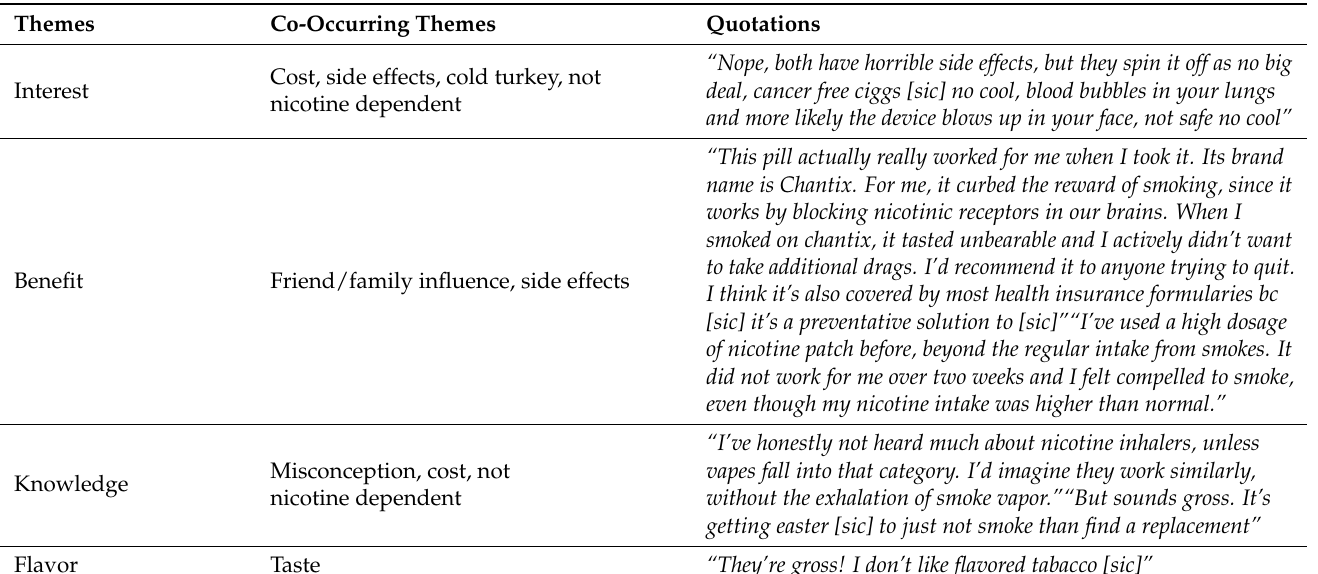
Table 3. Representative quotations displaying prevalent themes identified in Commune Smokefree Social